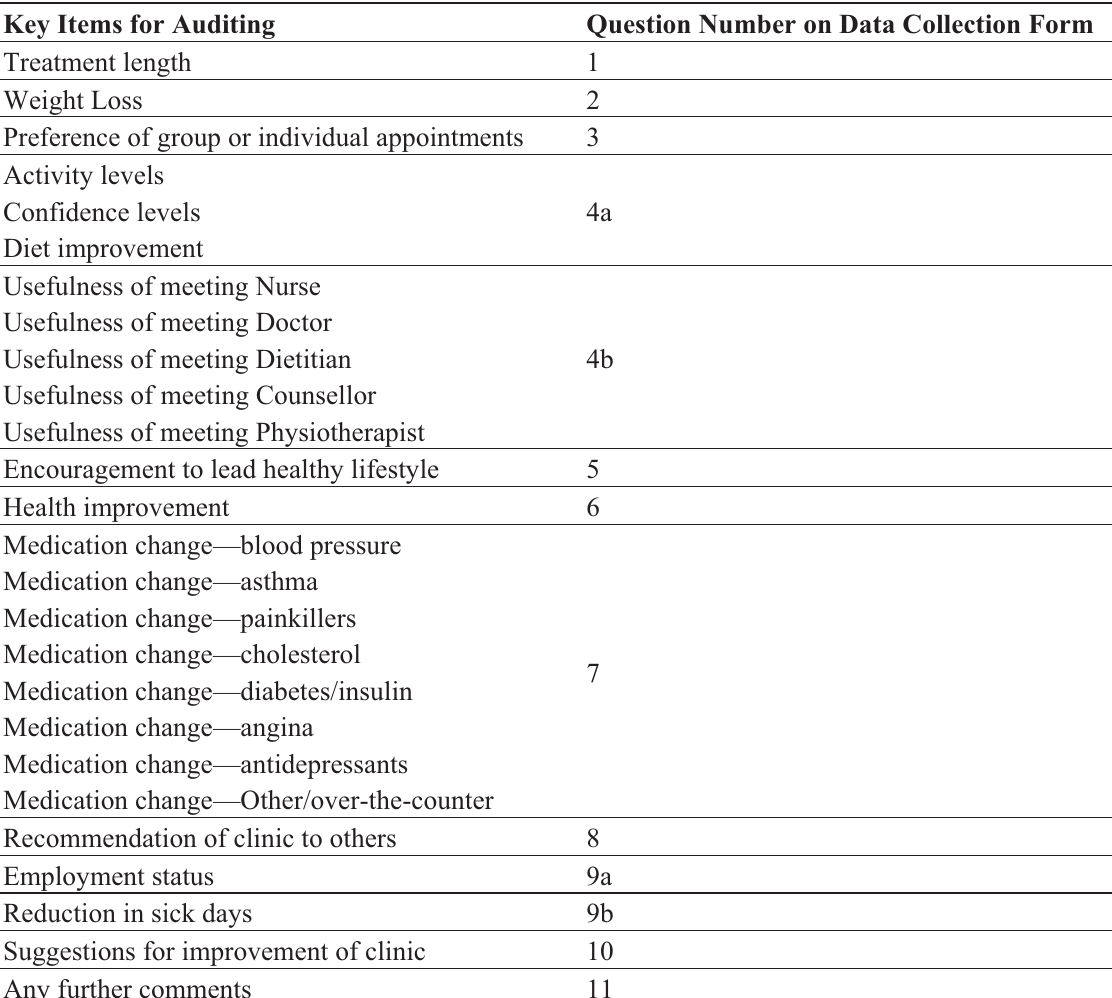
Table 1. A summary of the 26 key items audited (and the question number on our data collection form each refers